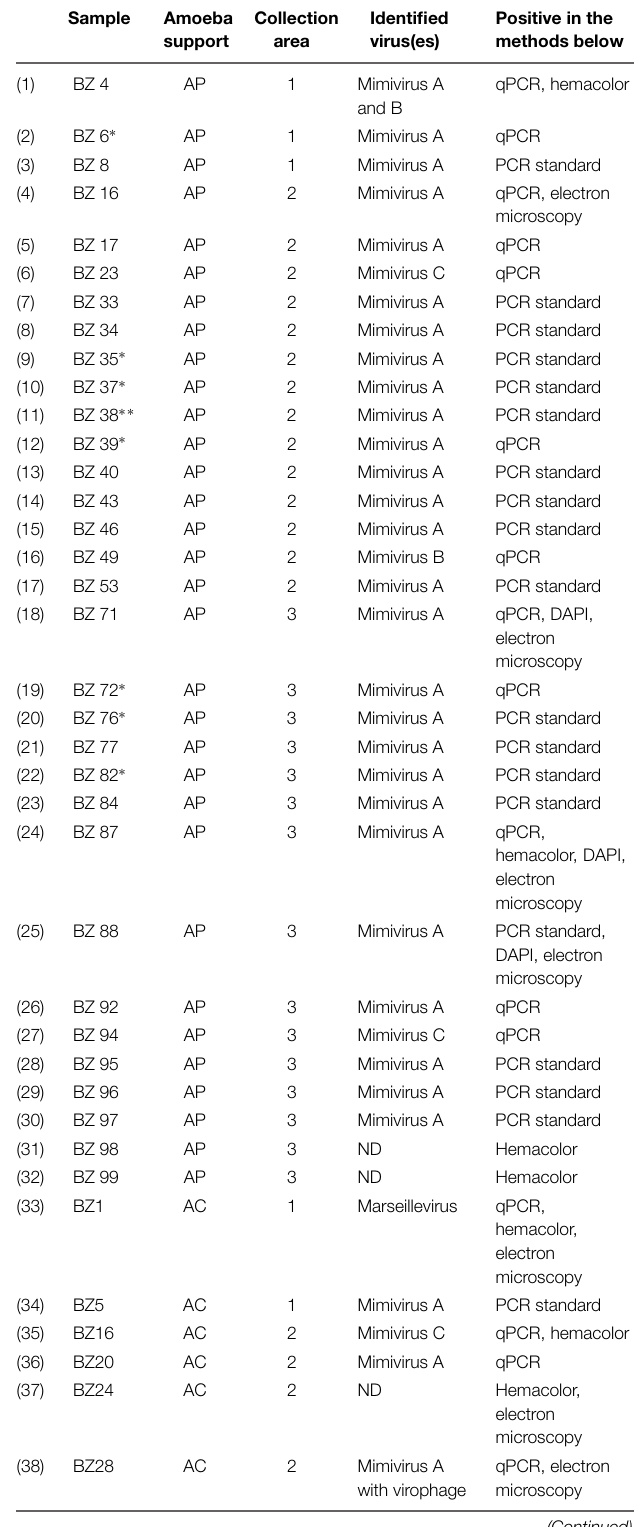
TABLE 1 | Brazilian virus isolated in environmental samples represented in collection area, virus detected by PCR system, amoebas support and the positives